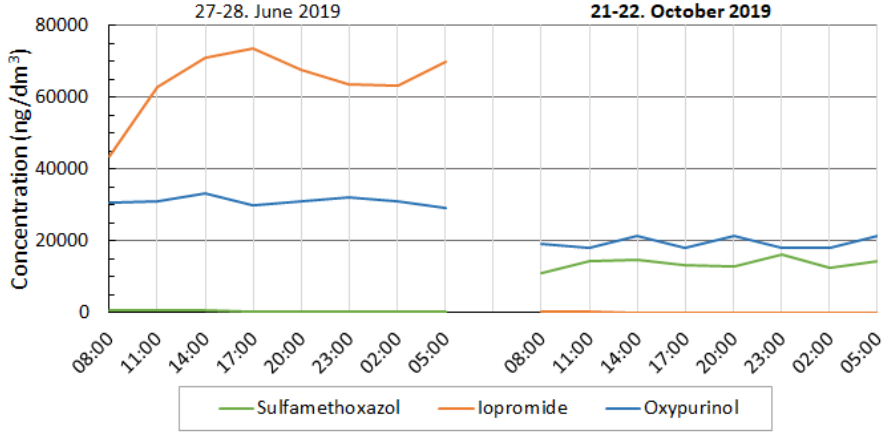
Figure 9. Water quality of the Hnevkovice WWTP effluent: iopromide, oxypurinol, and sulfamethoxazole.